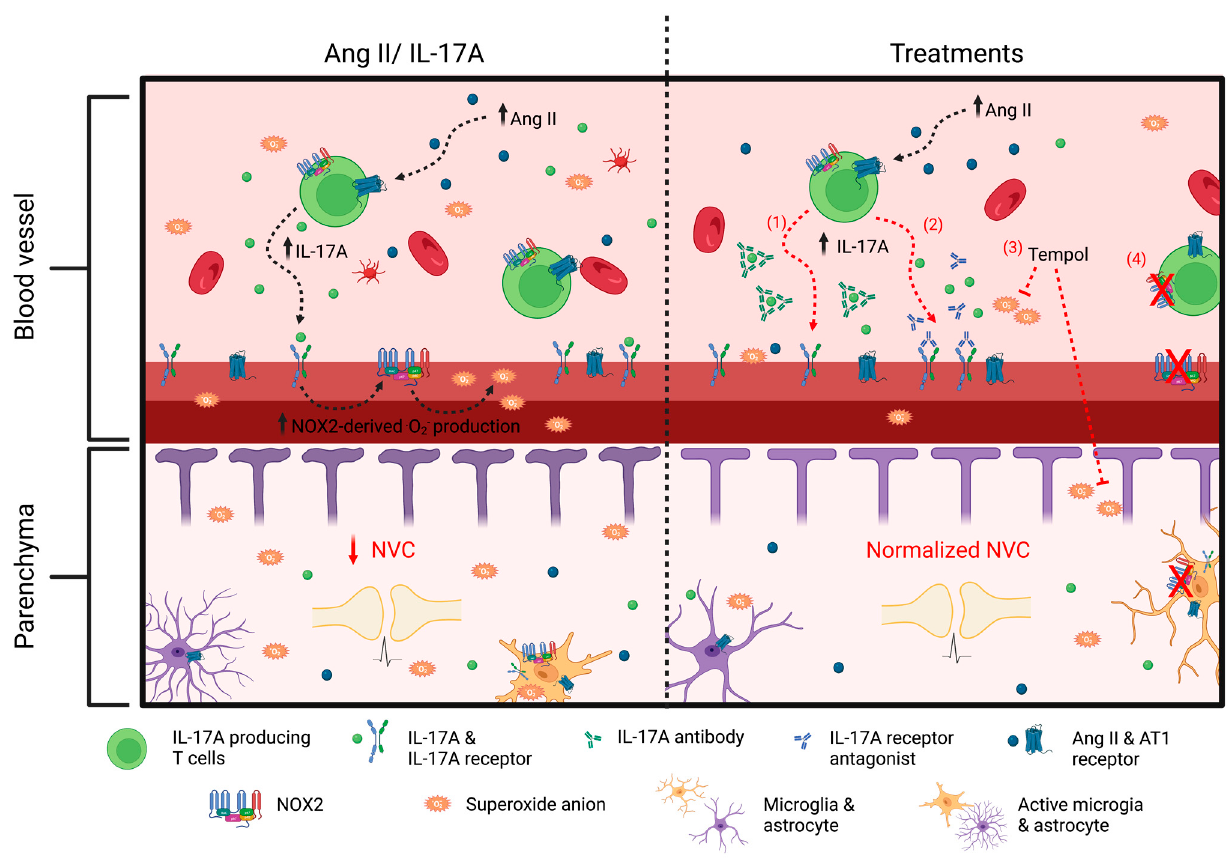
Figure 9. Interleukin-17A, through NOX2-derived superoxide anion production, is a modulator of neurovascular coupling impairment induced by angiotensin II. Increased angiotensin (Ang II) in hypertension leads to an inflammatory state with higher concentrations of circulating interleukin (IL)-17A. The latter, through NOX2-derived superoxide anion production, is an important mediator of neurovascular coupling (NVC) impairment induced by Ang II. ( 1 ) Neutralizing IL-17A or ( 2 ) inhibiting its receptor prevents Ang II-induced increased reactive oxygen species (ROS) production and neurovascular decoupling. Similarly, a treatment with ( 3 ) Tempol and ( 4 ) NADPH oxidase (NOX) 2 gene deletion prevents ROS production and NVC impairment induced by IL-17A. These findings suggest that IL-17A, through superoxide anion production, is an important mediator of cerebrovascular dysregulation induced by Ang II and could be a potential therapeutic target to prevent cerebrovascular dysfunction in hypertensive